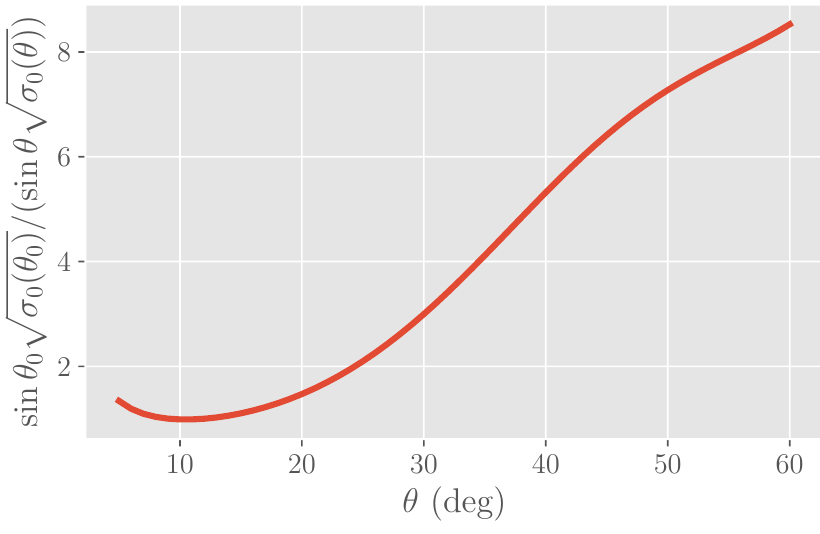
Figure 7. Relative radial velocity standard deviation referenced to the performance at the SKIM incidence angles, all other parameters being held constant. The penalty in the projection factor is outweighed by the greater brightness at near-nadir